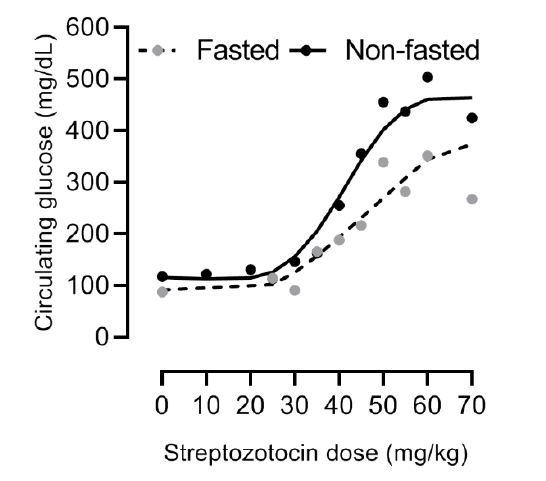
Figure 1: Relation between streptozotocin dose and fasted (14-16 hours) and non-fasted circulat- ing glucose, recorded from 24 h to 4 months after the streptozotocin injection in rats. Data were ob- tained from (Junod et al., 1969; Babu and Srinivasan, 1997; Rodrigues et al., 1997; Mythili et al., 2004) and (Hoftiezer and Carpenter, 1973; Bar-On et al., 1976; Ganda et al., 1976; Evan et al., 1984; Ar'Rajab and Ahrén, 1993; Rodrigues et al., 1997; Masiello et al., 1998; Gajdosík et al., 1999; Srinivasan et al., 2005; Akbarzadeh et al., 2007) for fasted and non-fasted states, respec- tively. In the case that data was presented in a graph, values were extracted using Photoshop, as previously reported (Gheibi et al.,